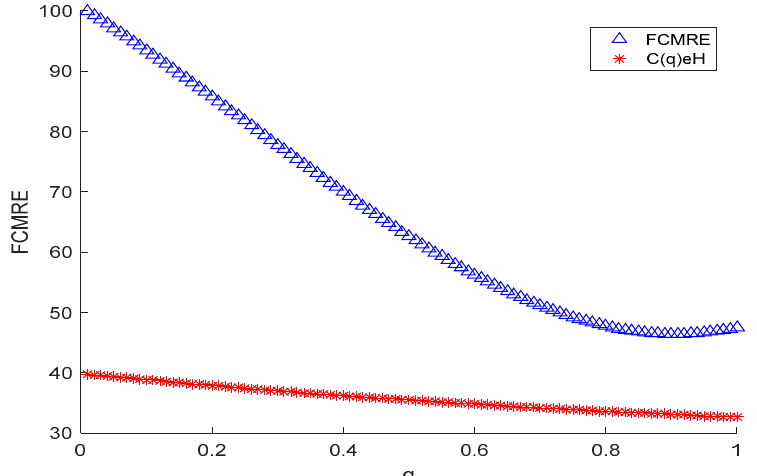
Figure 7. The fractional cumulative residual MRE of exponential distribution with λ 1 = 0.8, λ 2 = 0.5, and the values of C ( q ) e H .